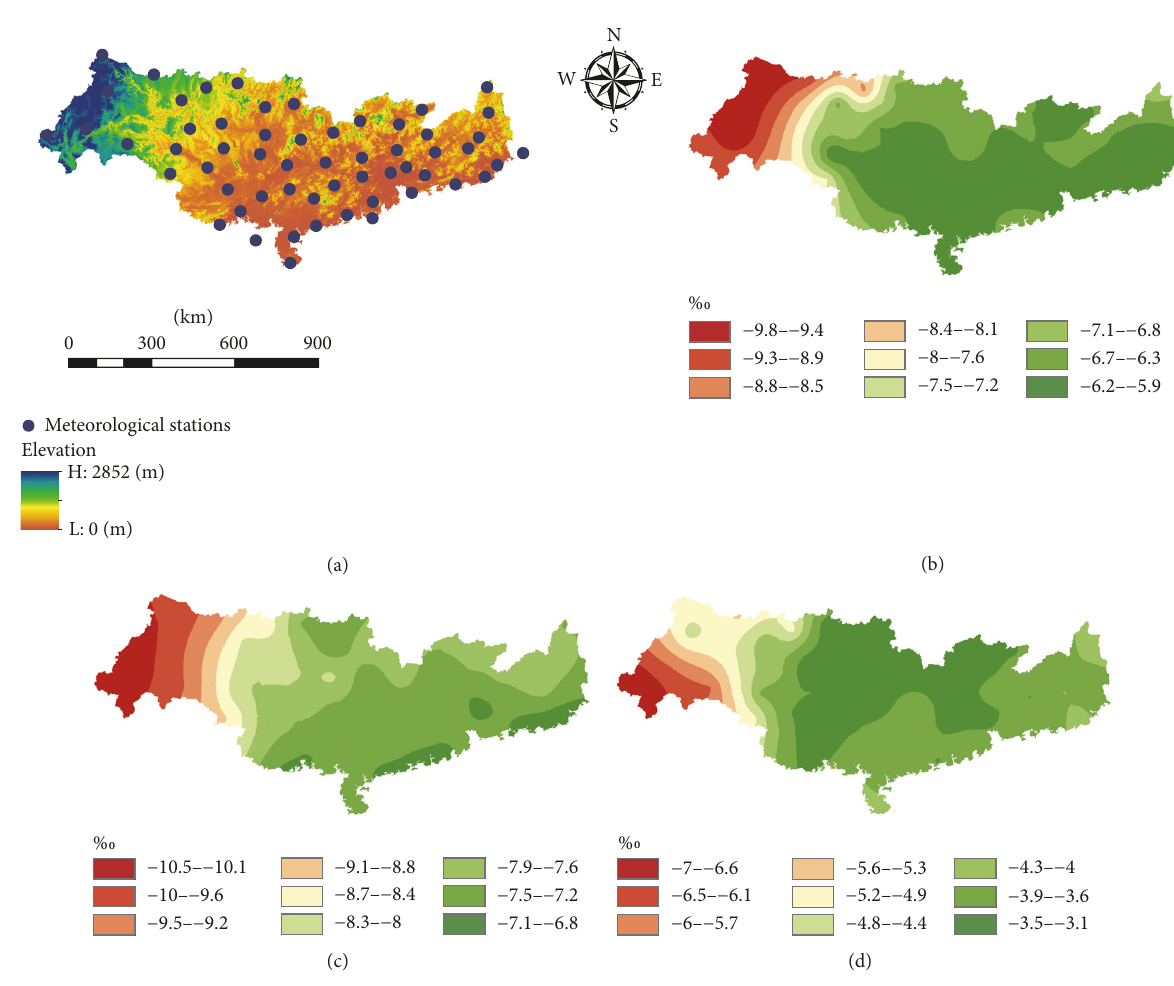
Figure 9: Spatial distribution of mean weighted precipitation 𝛿 18 O values over Pearl River basin of China based on the Kriging method from 1980 to 2011. Note: (a) represents meteorological stations in the Pearl River basin; (b) represents spatial distribution of the mean weighted annual precipitation 𝛿 18 O values by (8); (c) represents spatial distribution of mean weighted precipitation 𝛿 18 O values for the summer monsoon period by (9); (d) represents spatial distribution of mean weighted precipitation 𝛿 18 O values for the nonsummer monsoon period by